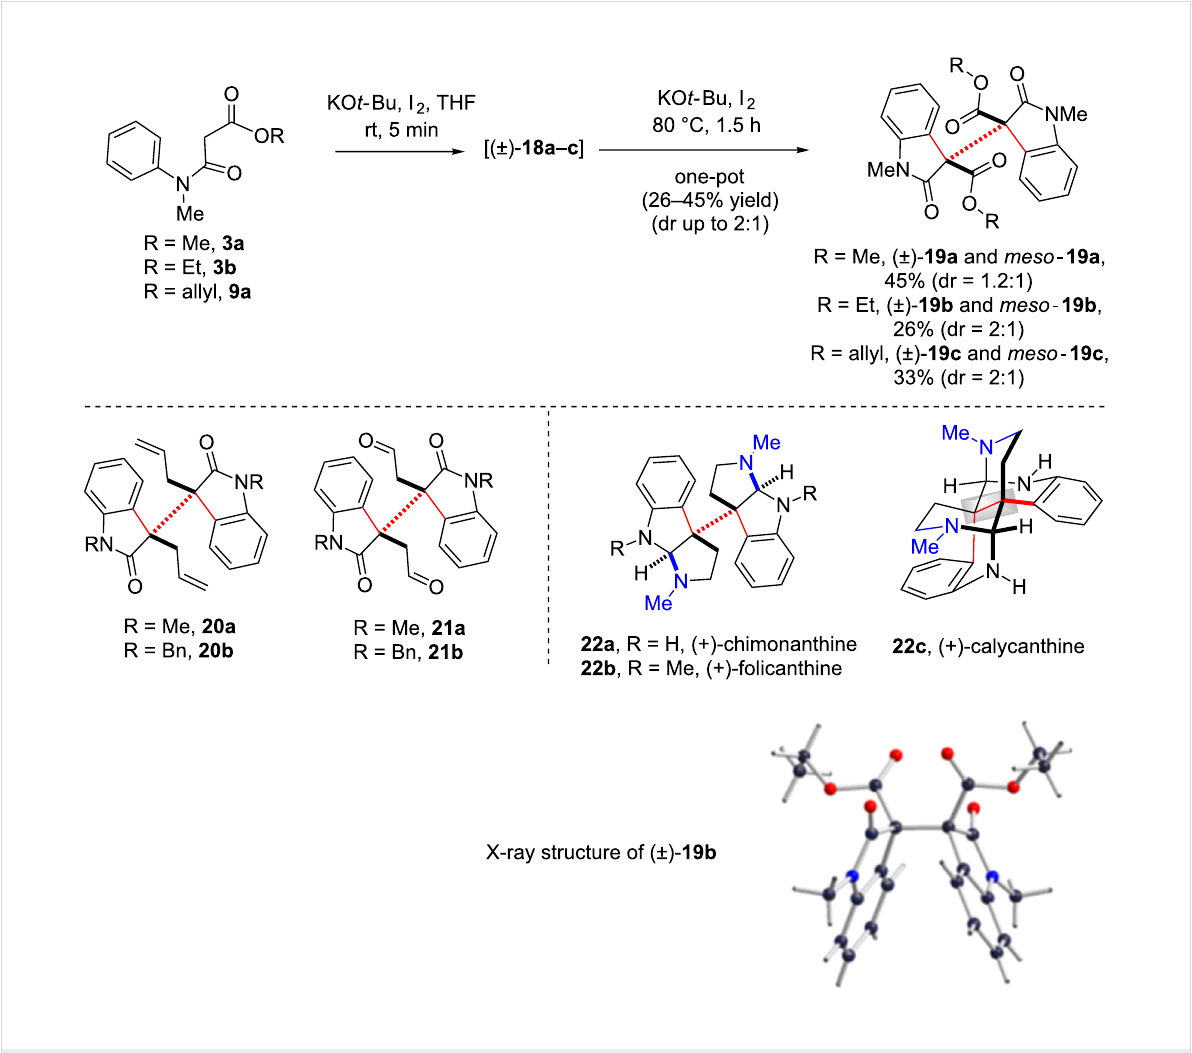
Scheme 5: Synthesis of dimeric 2-oxindoles utilizing IDC. The syntheses of 19a and b have been reproduced from [46].